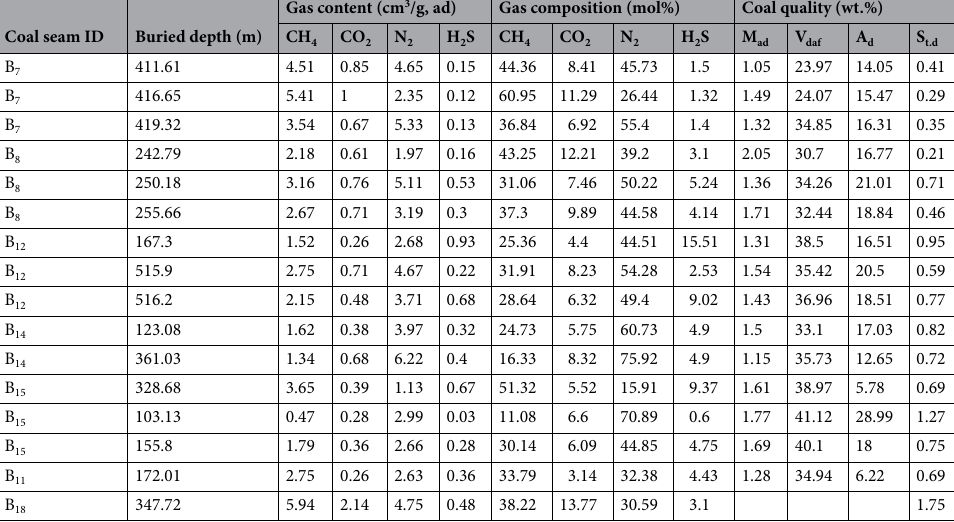
Table 1. The sampling depth ranged from 237 to 364 m, and the main components of the gas samples were CH 4 , CO 2 , N 2 , and H 2 S. The concentration of CH 4 ranged from 11.08% to 60.95%, with an average of 30.48%, the con- centration of CO 2 ranged from 4.4% to 13.77%, with an average of 7.77%, the concentration of N 2 ranged from 15.91% to 75.92%, with an average of 46.32%, and the concentration of H 2 S ranged from 0.6% to 15.51%, with an average of 4.74%. The moisture content ranged from 1.05% to 2.05%, with an average of 1.48%, the volatile yield ranges from 23.97% to 41.12%, with an average of 34.34%, the ash yield ranged from 14.05% to 28.99%, with an average of 16.44%, and the total sulfur content ranged from 0.21% to 1.75%, with an average of 0.71%. The geochemical characteristics of the coal seam groundwater samples are shown in Table 2. The pH value of the water samples ranged from 6.95 to 8.3, with an average of 7.59, SO 4 2− content ranged from 237.08 mg/L to 6676.2 mg/L, with an average of 2179.77 mg/L, HCO 3− + CO 32− content ranged from 137.42 mg/L to 1888 mg/L, with an average of 682.82 mg/L. The concentration of SO 42− ion ranged from 17.12% to 88.30%, with an average of 55.69%, HCO 3− + CO 32− ion concentration ranged from 1.61% to 54.75%, with an average of 22.38%, and the value of γHCO 3− /γSO 42− ion ranges from 4.92% to 182.48%, with an average of 60.72%.